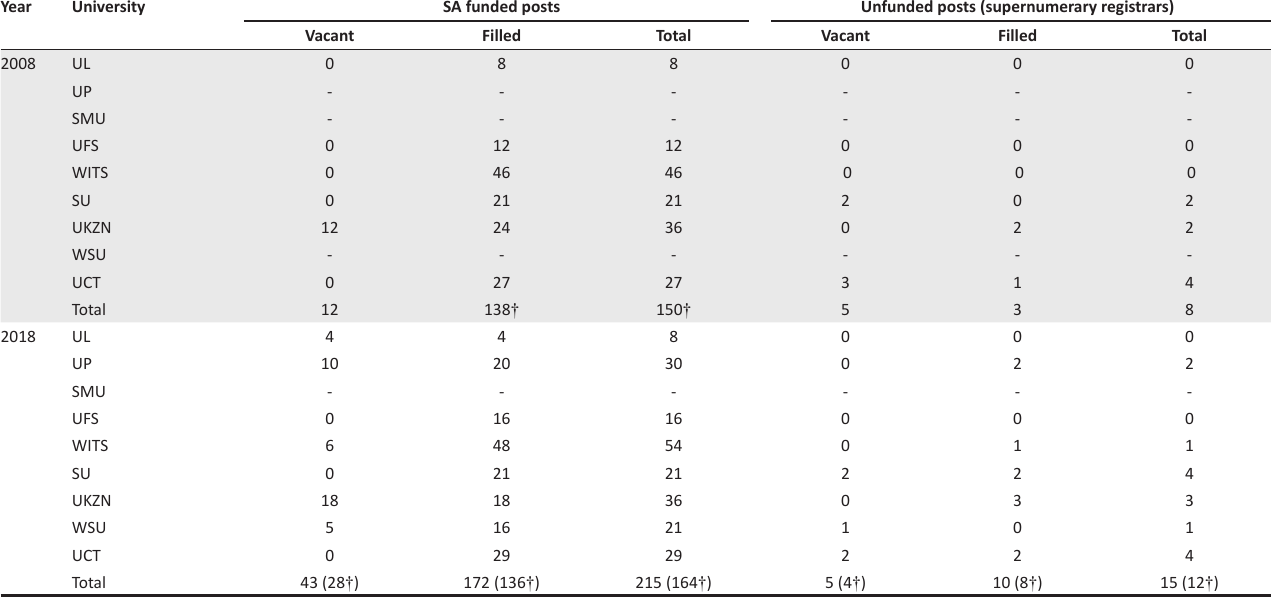
TABLE 1: Specialist training